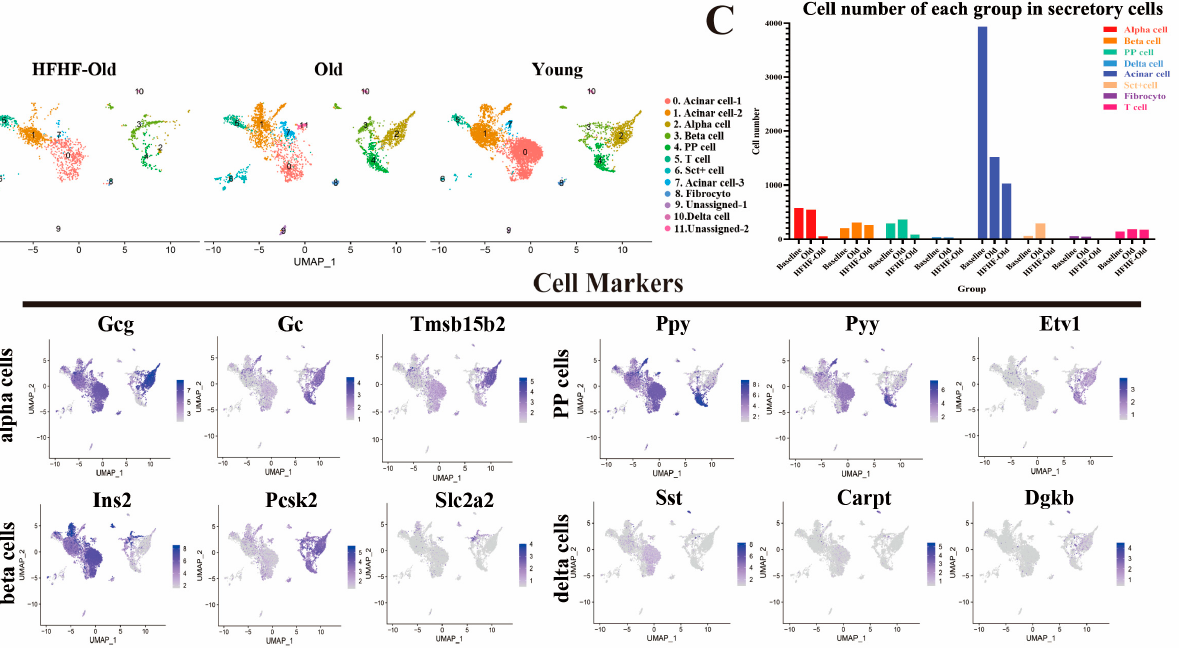
Figure 6 . Distinct cell populations with transcriptional signatures in secreting islet cells. ( A ) UMAP plot characterizing the differences in secretory cell subpopulation distribution at the beginning (young) and after 18 months (HFHF-old, old) of diet feeding. Each point represents one cell. The distance between the two points is determined by the Pearson correlation of the 500 most highly expressed genes in each cell. Cell identity is recognized by the expression of marker genes. ( B )